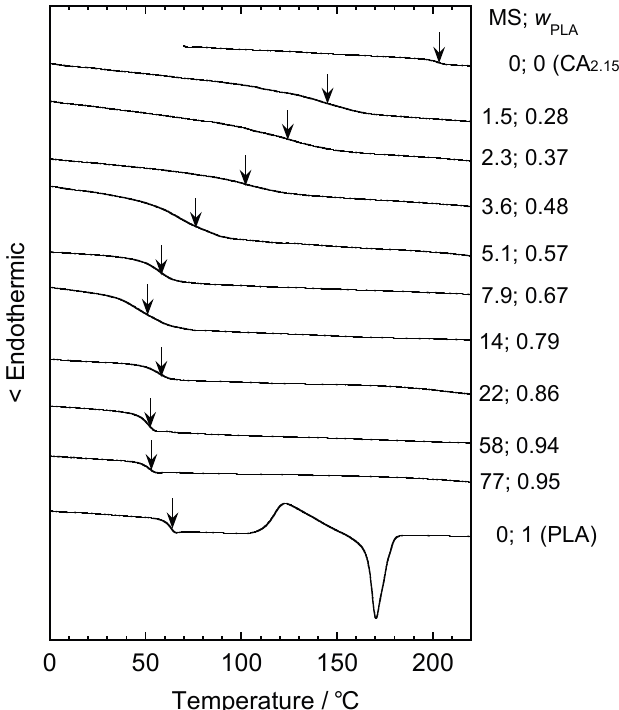
Figure 18. DSC thermograms of CA 2.15 , PLA, and CA 2.15 - g -PLAs obtained at various MS values during in the second heating scan. Arrows mark the T g positions taken as the midpoints of the heat flow discontinuity. Reproduced with permission from ref. [55]. Copyright 2003 Elsevier Science Ltd.